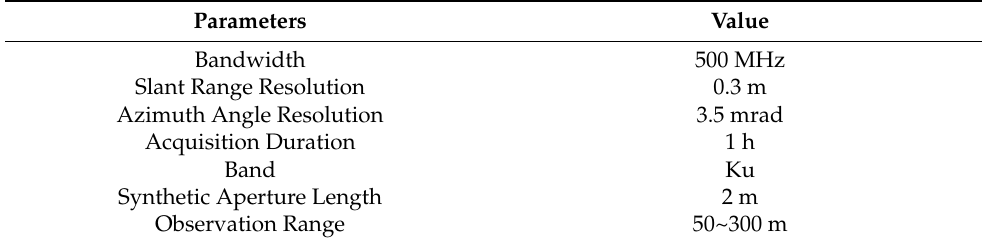
Figure 1. ( a ) a photo of the SDMR-1 GB-SAR system, ( b ) a photo of the Linjiaping railway slope. The observation range is in the yellow dashed line box. Since the terrain is relatively flat and ob- servation range is small, we define this area as a 2D observation scenario. Table 1. The SDMR-1 GB-SAR system parameters. Table 1. The SDMR-1 GB-SAR system